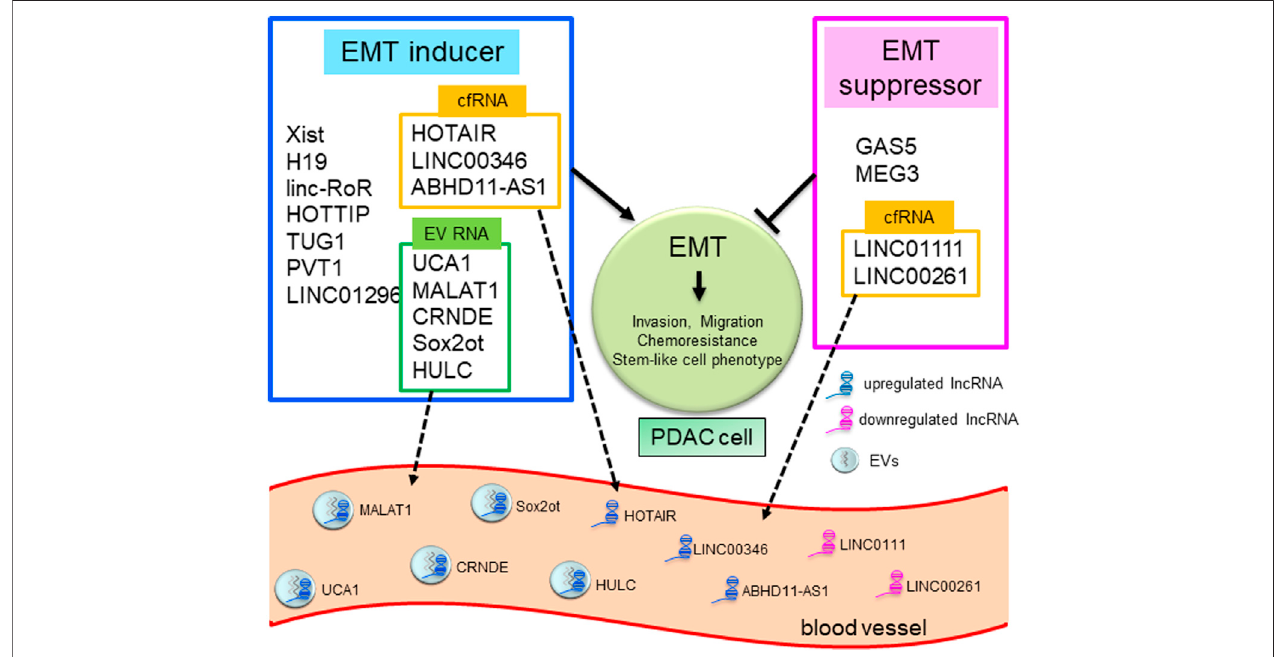
FIGURE1| LncRNAsinEMTandliquidbiopsyinhumanPDAC.SchematicoverviewshowinglncRNAsmediatingtheEMTpathwayandastoolsforliquidbiopsyin PDAC. LncRNAs as EMT inducers or suppressors are summarized in blue or red frames. LncRNAs in yellow or green frames are reported to exist in blood as EV- encapsulated RNAs or cell-free RNAs (cfRNAs) and can be used for liquid biopsy.